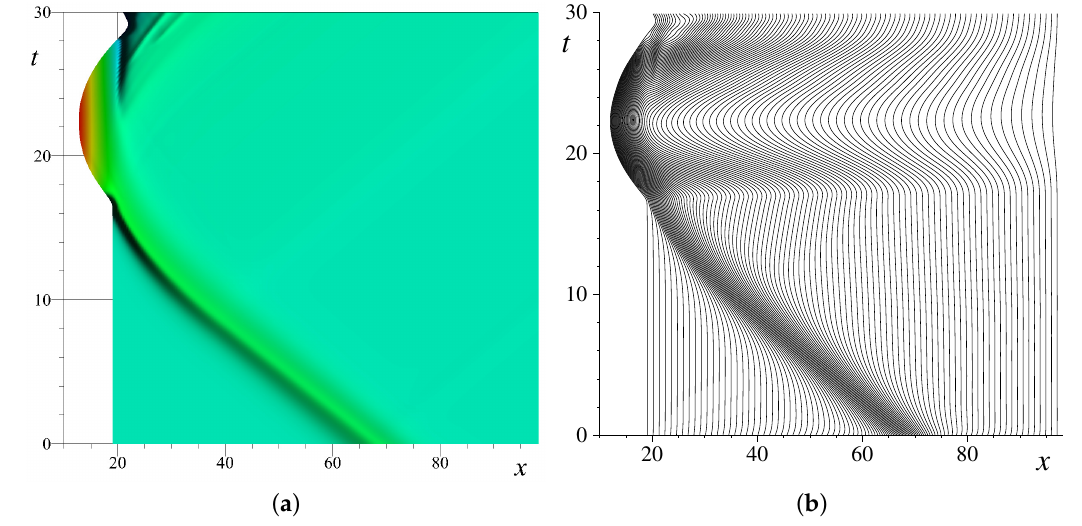
Figure 7. The solitary wave run-up simulation on a sloping beach with nonlinear shallow water equations: ( a ) The free surface elevation evolution and ( b ) the trajectories of grid nodes in